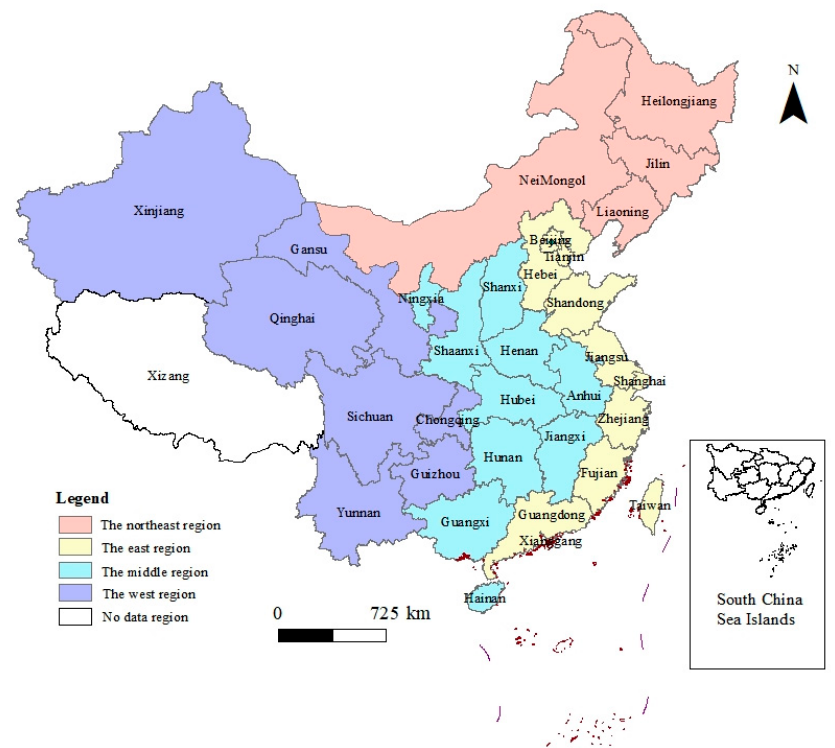
Figure 3 . Function index distribution of rural residential land in different provinces and regions in China.